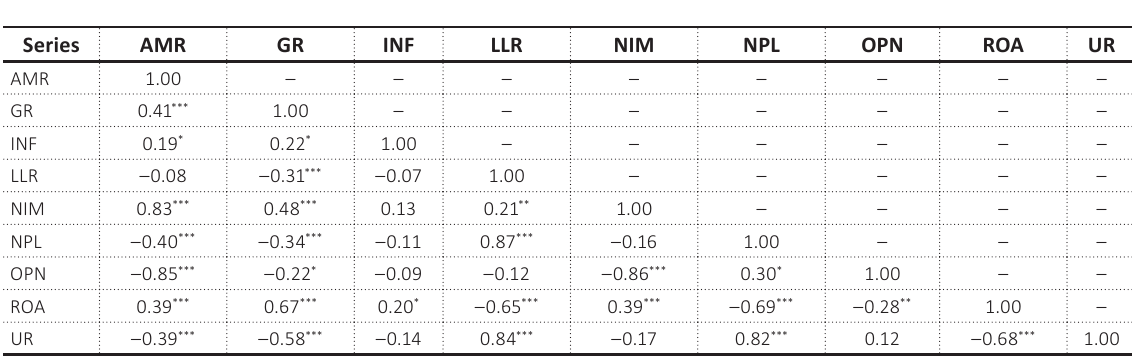
Table 2. Pearson correlation